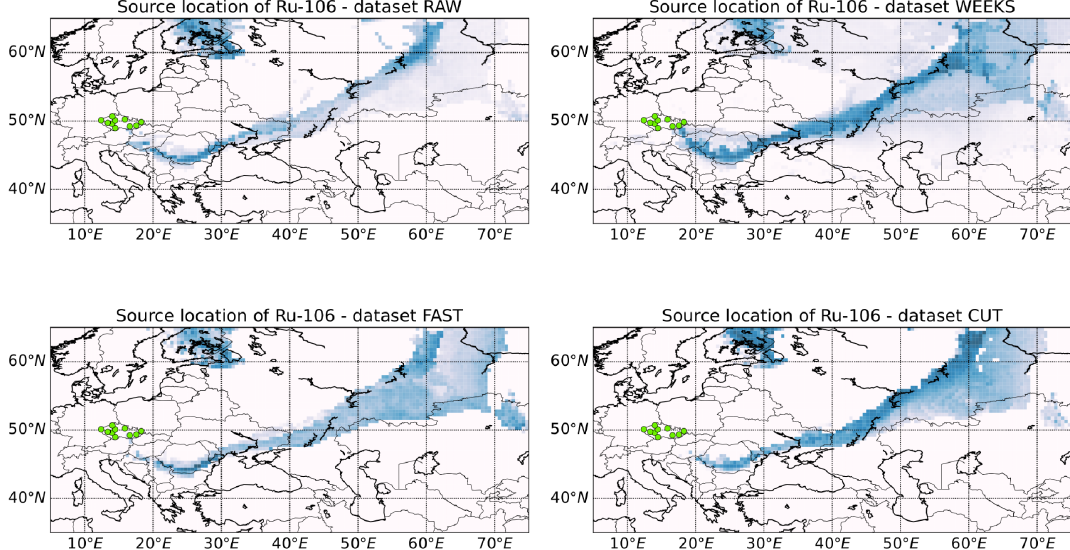
Figure 5. Source location of the 106 Ru release via the marginal log likelihood, where the observed data are explained by a release from a grid cell using the LS-APC-VB method HYSPLIT atmospheric transport model coupled with GFS 0.5 ◦ meteorological data. The dataset that has been used is indicated in the titles of each map. The measuring sites are displayed using green dots. Table 2. This table summarizes and compares previous studies on the 106 Ru release in 2017, focusing on the total release, the source location, and the temporal character. The last row contains results based on the Czech FAST